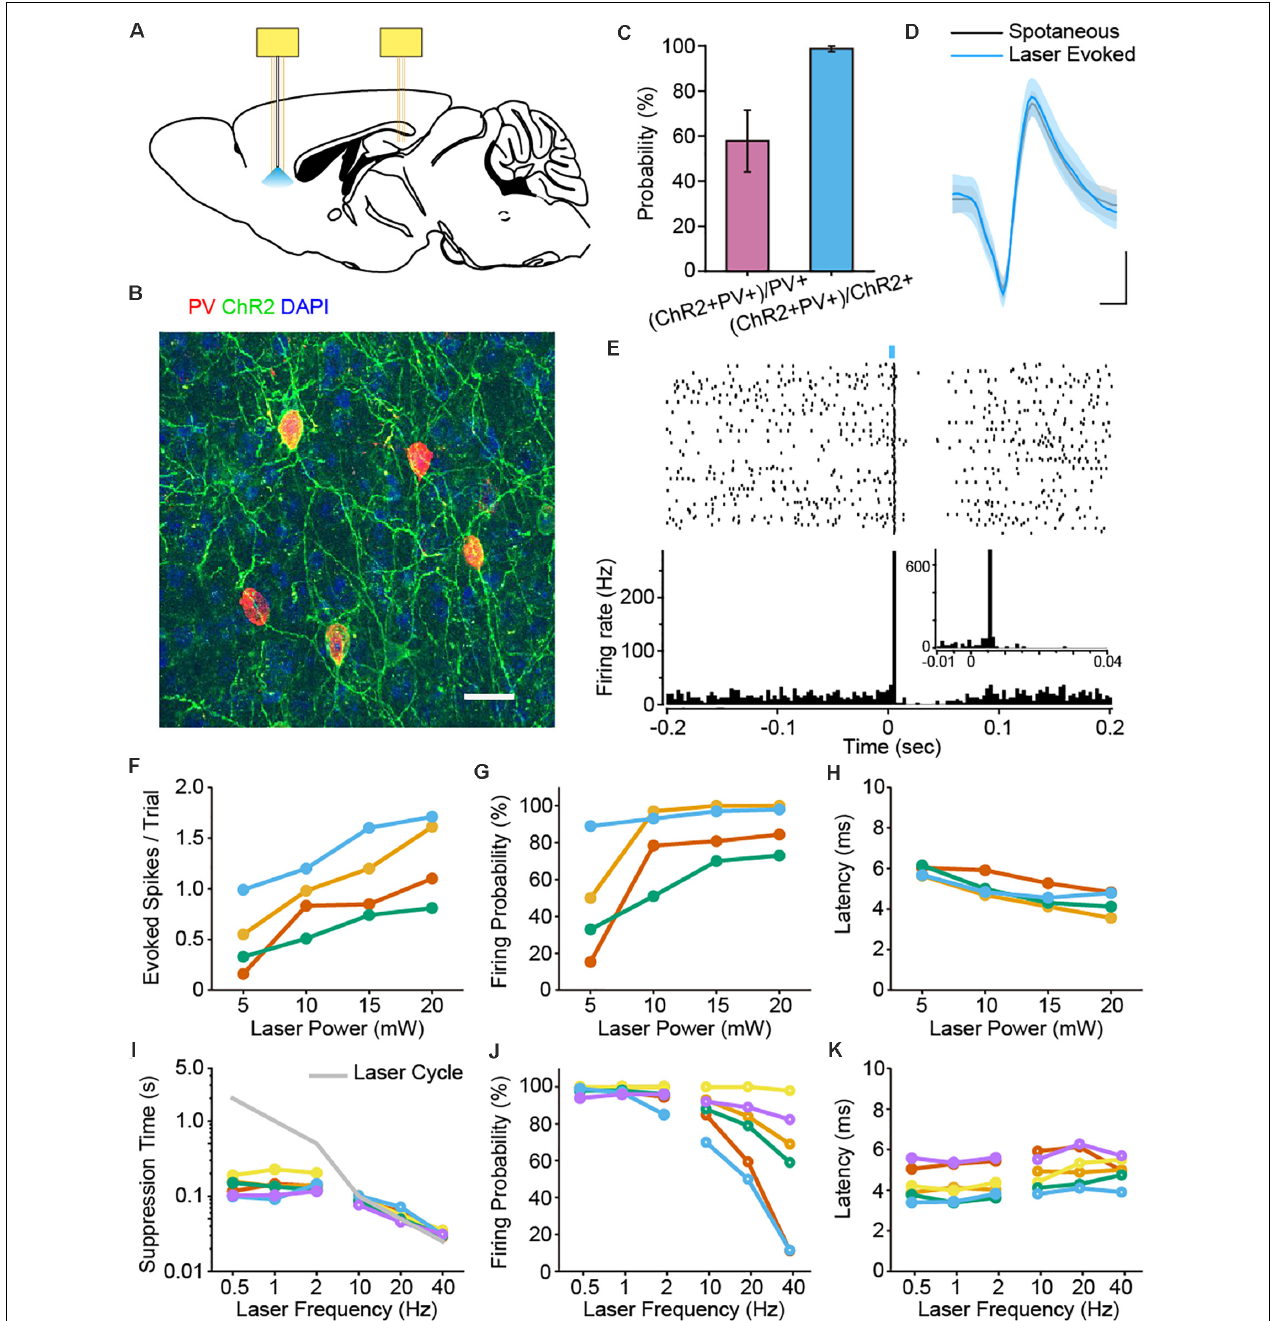
FIGURE 1 | Optogenetic identification of PFC PV interneurons and characterization of laser stimulation parameters. (A) Schematic diagram of the placement of two electrode bundles: an optrode targeting the PFC and a tetrode bundle in the dCA1 of the hippocampus. (B) Immunostaining of PV (red), EYFP (green) and DAPI (blue) confirmed the co-localization of PV and ChR2 in the PFC of PV-ChR2-EYFP transgenic mice. Scale: 50 µ m. (C) Expression efficiency statistics revealed that 98.63% ± 1.28% of the ChR2 + neurons were PV+, whereas 57.82% ± 13.67% of the labeled PV neurons were ChR2 + ( n = 7 mice). (D) Example spike waveforms from one PV neuron. The waveforms of the spontaneous (black) and laser-evoked spikes (blue) were almost identical (mean ± SD of 100 spikes, Pearson Correlation, R = 0.998, p = 1.27e-62). Scale: 0.2 ms, 0.2 mV. (E) Peri-stimulus raster and histogram of an example PV interneuron upon laser pulse stimulation (1 Hz, 5 ms pulse, 100 trials, bin = 3 ms). Note the brief suppression response right after the laser evoked firing of PV neuron. Enlarged view shows light-induced spike latency around 6 ms (1 Hz, 5 ms pulse, 100 trials, bin = 1 ms). (F–H) The impact of laser power on the number of evoked spikes per trial (F) , firing probability (G) and spike latency (H) for PV interneurons. Each color corresponds to a single neuron, the same below ( n = 4 neurons). Neuronal firing responses increased with higher laser stimulation power. (I–K) The impact of laser frequency on suppression time (I) , firing probability (J) and latency (K) for PV interneuron activation. Solid circles, lower frequency; open circles, higher frequency ( n = 6 neurons). Neuronal firing probability decreased at higher stimulation frequencies (J) .